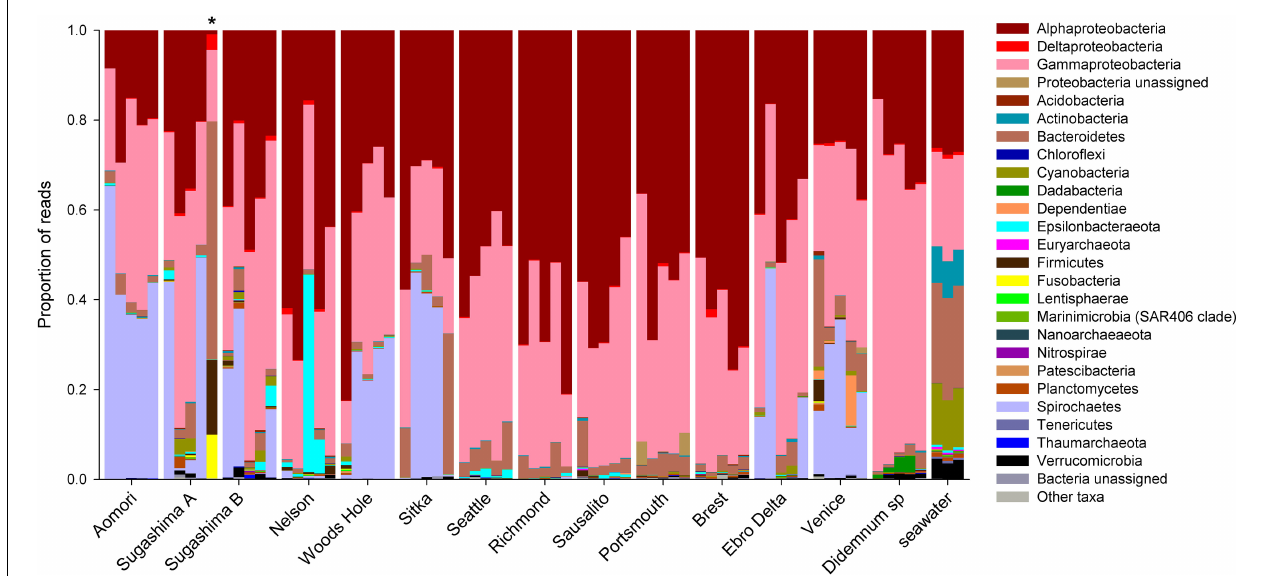
FIGURE 2 | Taxonomic composition of the microbial community for each of the 73 samples. The proportions of number of reads at phylum level are shown, except for Proteobacteria, which are divided into their major classes. *Sample with a visibly different microbial taxonomic composition.